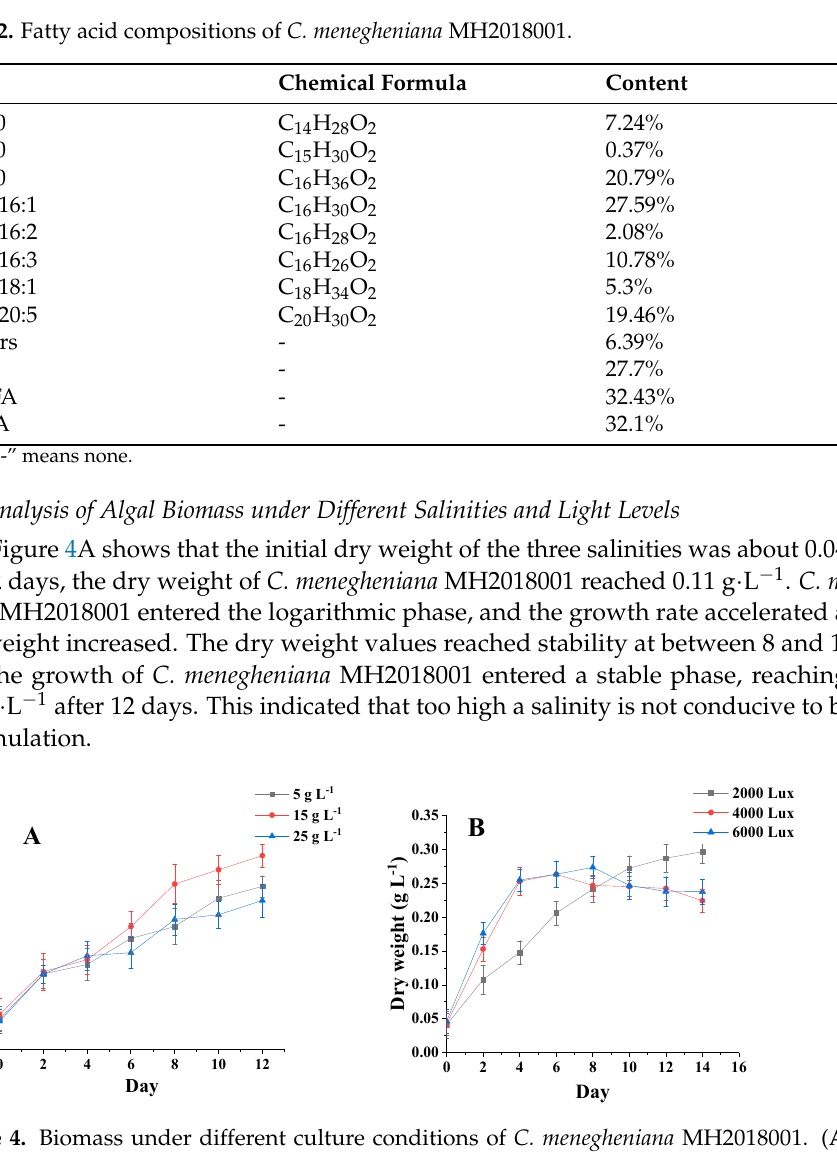
Figure 4. Biomass under different culture conditions of C. menegheniana MH2018001. ( A ) represents the biomass at different NaCl concentrations; ( B ) represents the biomass under different light conditions). The results are presented as mean ± SE ( n = 3).